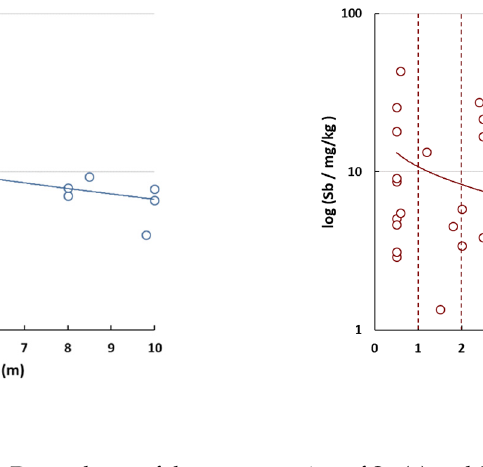
Figure 4. Dependence of the concentration of Sn ( a ) and Sb ( b ) in the soil, expressed in logarithmic form, and the distance of the sampling point from the railway tracks.